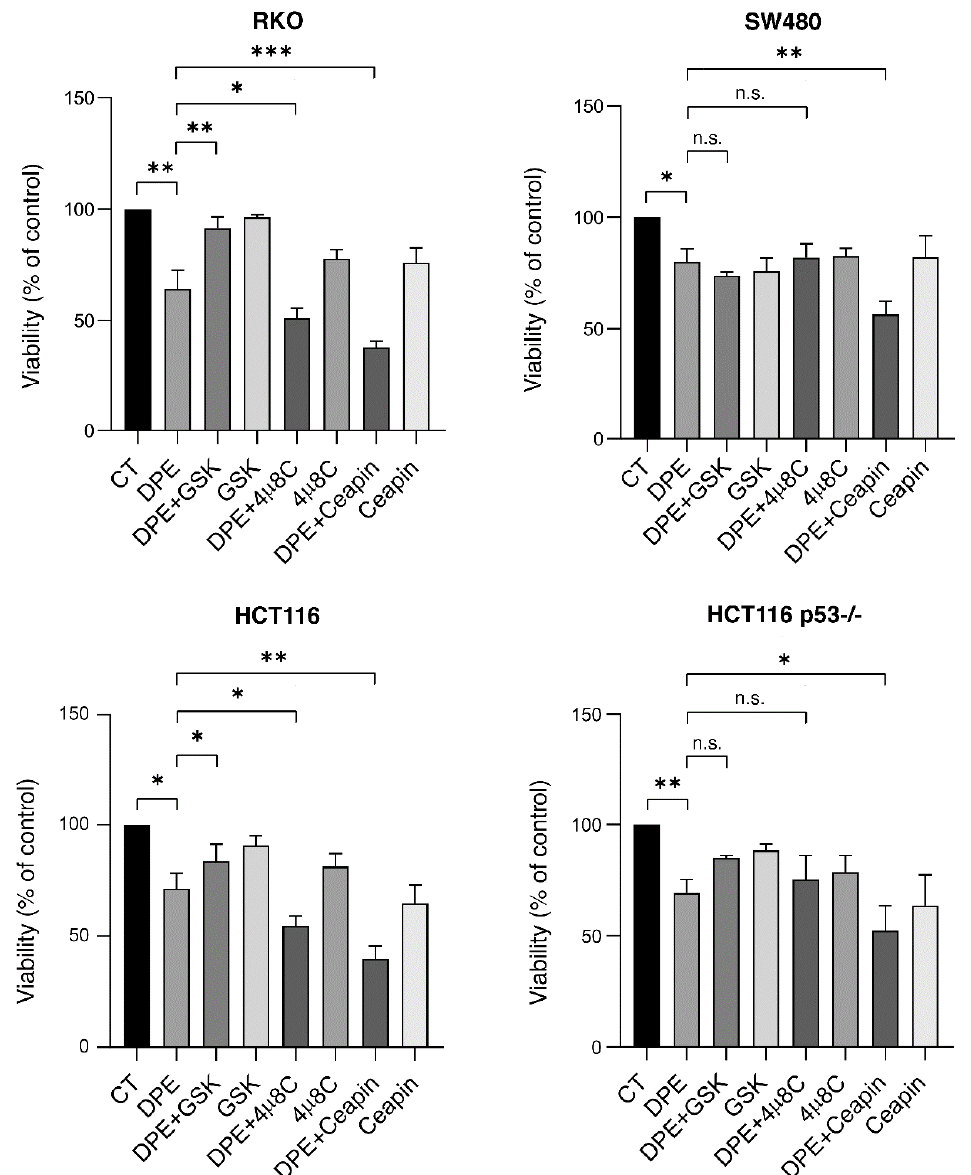
Figure 5. UPR sensor inhibitors differently affect cell survival of DPE-treated cells. Cell viability levels of RKO, SW480, HCT116, and HCT116 p53-/- cell lines pre-treated with 4 µ 8C (10 µ M), GSK (0.5 µ M), or ceapin (12 µ M) and then treated with DPE (50 µ M) or left untreated as control (CT), as measured via trypan blue exclusion assay after 48 h of culture. Note: *** p < 0.001 ** p < 0.01, * p < 0.05. Not significant (n.s.).